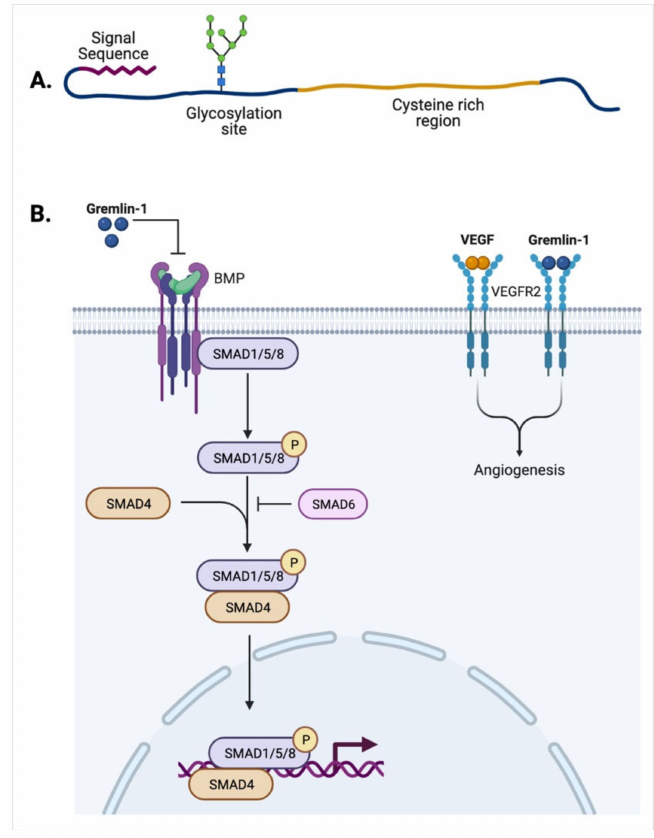
Figure 1. Structure and Function of Gremlin-1. ( A ) Schematic diagram representing the structure of Gremlin-1 with its signal sequence, glycosylation site and cysteine-rich region. ( B ) Gremlin-1 can bind and inhibit the BMP signaling pathways including the SMAD family as well as direct binding to vascular endothelial growth factor receptor (VEGFR) and activating its downstream signaling